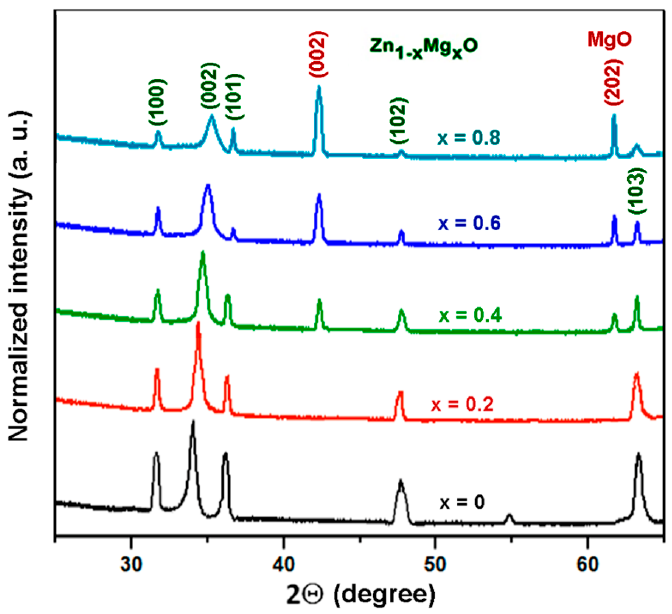
Figure 7. XRD pattern of Zn 1 − x Mg x O alloy films deposited by aerosol spray pyrolysis. The (002) reflex is gradually shifted to larger diffraction angles when increasing the x value. The intensity of reflexes coming from the wurtzite phase decreases as the x value increases higher than 0.4, with a concomitant emerging of (002) and (202) reflexes from the cubic rock salt phase. Nevertheless, reflexes from the wurtzite phase persist in the pattern registered for the x value of 0.8, suggesting that the wurtzite phase is present in films up to an x value of 0.8. Similar to samples prepared by spin coating, the XRD data collected on samples prepared by aerosol spray pyrolysis are corroborated by the results of RS spectroscopy presented in Figure 8. The intensity of Raman modes coming from the wurtzite phase decreases with the increase of the x value in Zn 1 − x Mg x O films, and the E 2low mode shifts to higher wavenumbers.